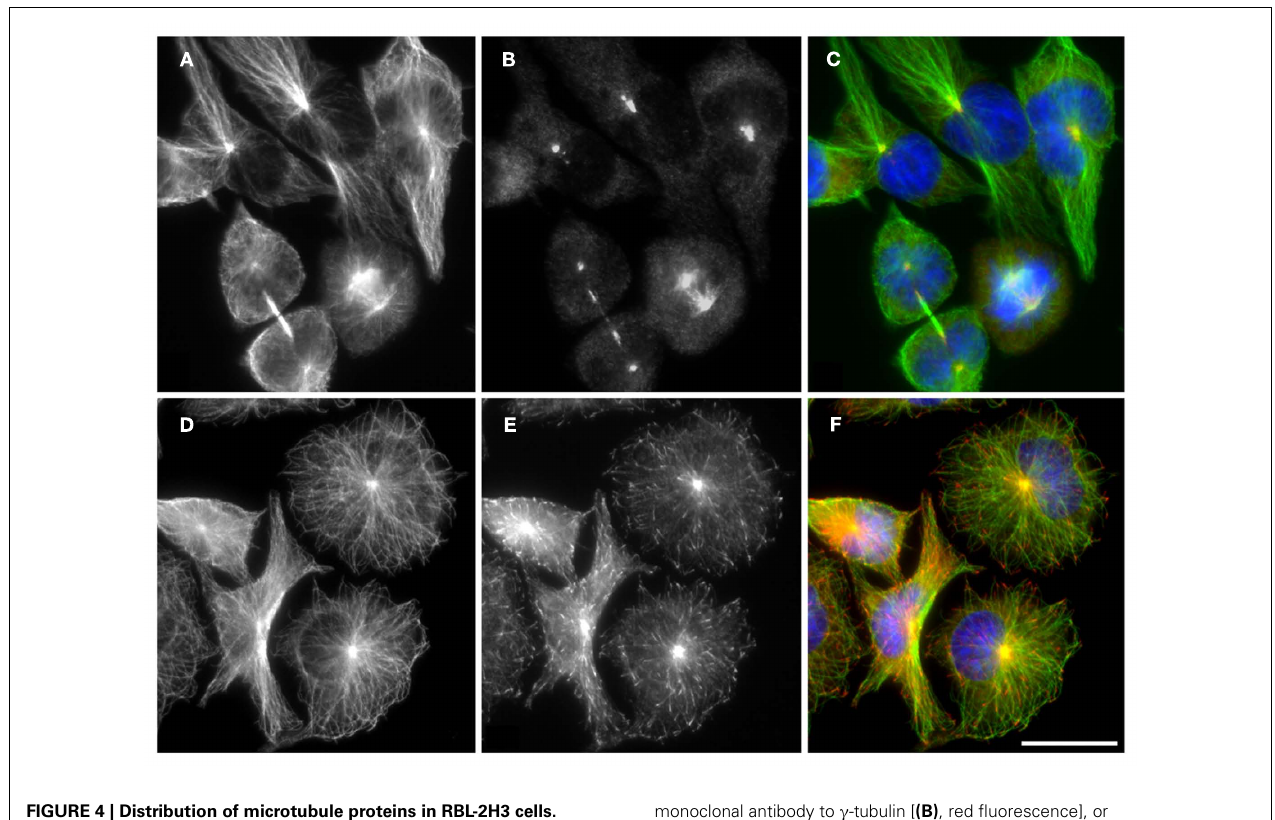
monoclonal antibody to γ -tubulin [ (B) , red fluorescence], or monoclonal antibody to EB1 [ (E) , red fluorescence]. DNA was stained with DAPI (blue). Superposition of α -tubulin and γ -tubulin is shown in (C) . Superposition of α -tubulin and EB1 is shown in (F) . Scale bar,